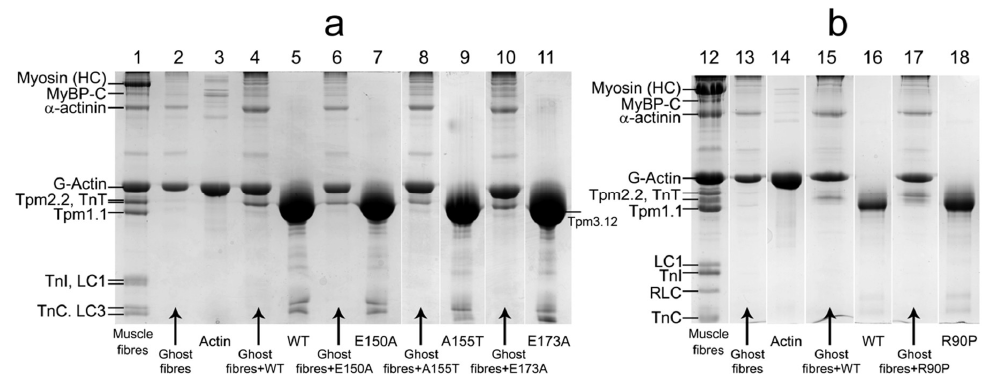
Figure 1. SDS-PAGE of muscle fibers (rabbit psoas) and tropomyosins used in the assays. Verification of myosin and Tpm–TN extraction from muscle fibers during the preparation of ghost fibers was carried out for each experiment ( a , b ). (4–11, 15–18) Analysis of the binding of wild-type (WT) and mutant Tpms to actin in ghost fibers shows that E173A, R90P, E150A, and A155T substitutions do not affect the binding of Tpm to actin. Seven to ten fibers each 15–20 mm in length were loaded per gel. Designations: Myosin HC—myosin heavy chains; LC1, LC3, and RLC—myosin light